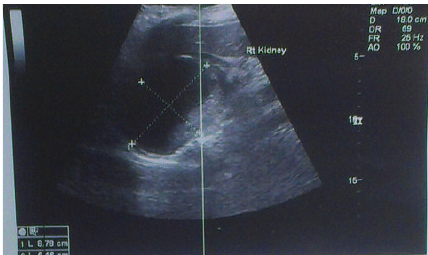
Figure 1: Ultrasound of the abdomen. Tumor between right kidney and liver, with mixed echogenicity, low vascularity, and dimensions 9 × 7.5 cm.